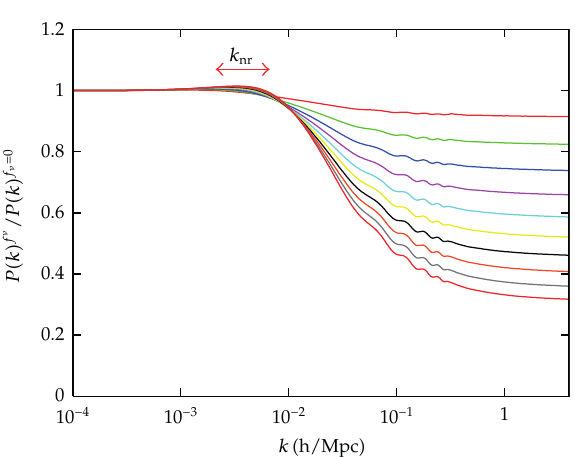
Figure 7: Ratio of the matter power spectrum including three degenerate massive neutrinos with density fraction f ν to that with three massless neutrinos. The parameters (cid:2) ω m , Ω Λ (cid:3) (cid:7) (cid:2) 0 . 147 , 0 . 70 (cid:3) are kept fixed, and from top to bottom the curves correspond to f ν (cid:7) 0 . 01 , 0 . 02 , 0 . 03 ,... , 0 . 10. The individual masses m ν range from 0 . 046 to 0 . 46eV, and the scale k nr from 2 . 1 × 10 − 3 h Mpc − 1 to 6 . 7 × 10 − 3 h Mpc − 1 as shown on the top of the figure, from (cid:4) 8 (cid:5)